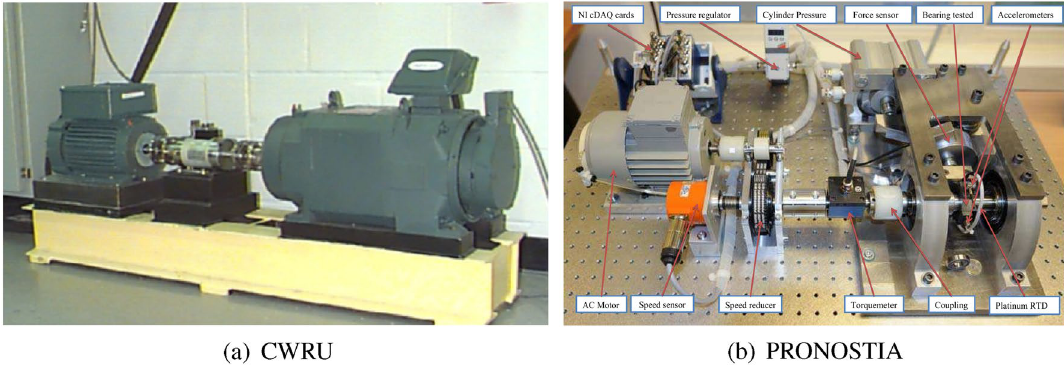
Figure 5. Bearing test benches: CWRU for fault classification ( a ) and PRONOSTIA for RUL prediction ( b ).